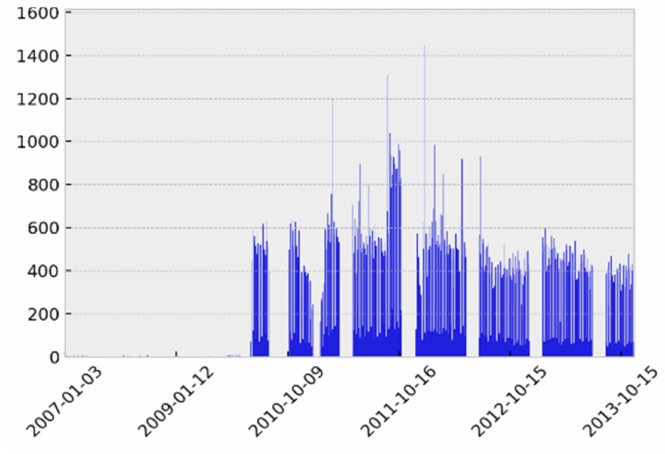
Figure 2. Amount of Bloomberg news by publication date.